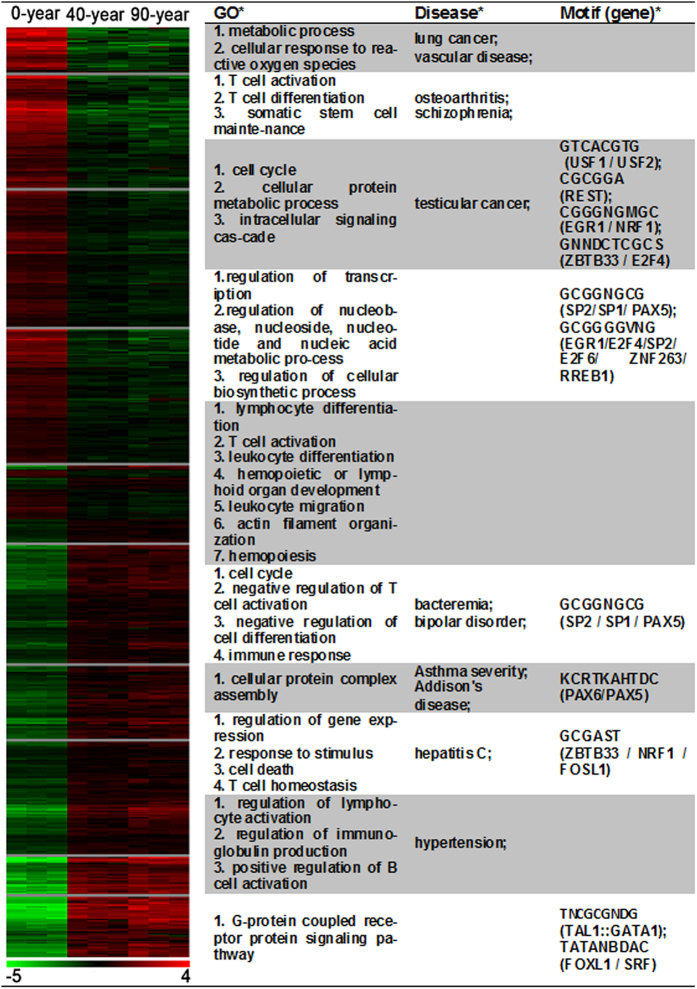
In-depth analyses of transcriptome features characterizing CD4+ T cell during the aging process.Illustration of gene expression patterns and corresponding biological theme enrichments for each of the ten gene clusters. The patterns of gene expression in 0-year (NB), 40-year (MA) and 90-year (LL) with green to red blocks, symbolizing relative expression levels corresponding to the scale bar at the bottom. Various biological annotations were mined to determine enrichments of biological relevance, as highlighted by GO analysis for functional enrichments (P-values < 0.05), motifs of JASPAR conserved transcription factor binding sites for regulatory enrichments (P-values < 0.05), and Online Mendelian Inheritance in Man (OMIM) disorder-gene association information for disorder enrichments (P-values < 0.05).